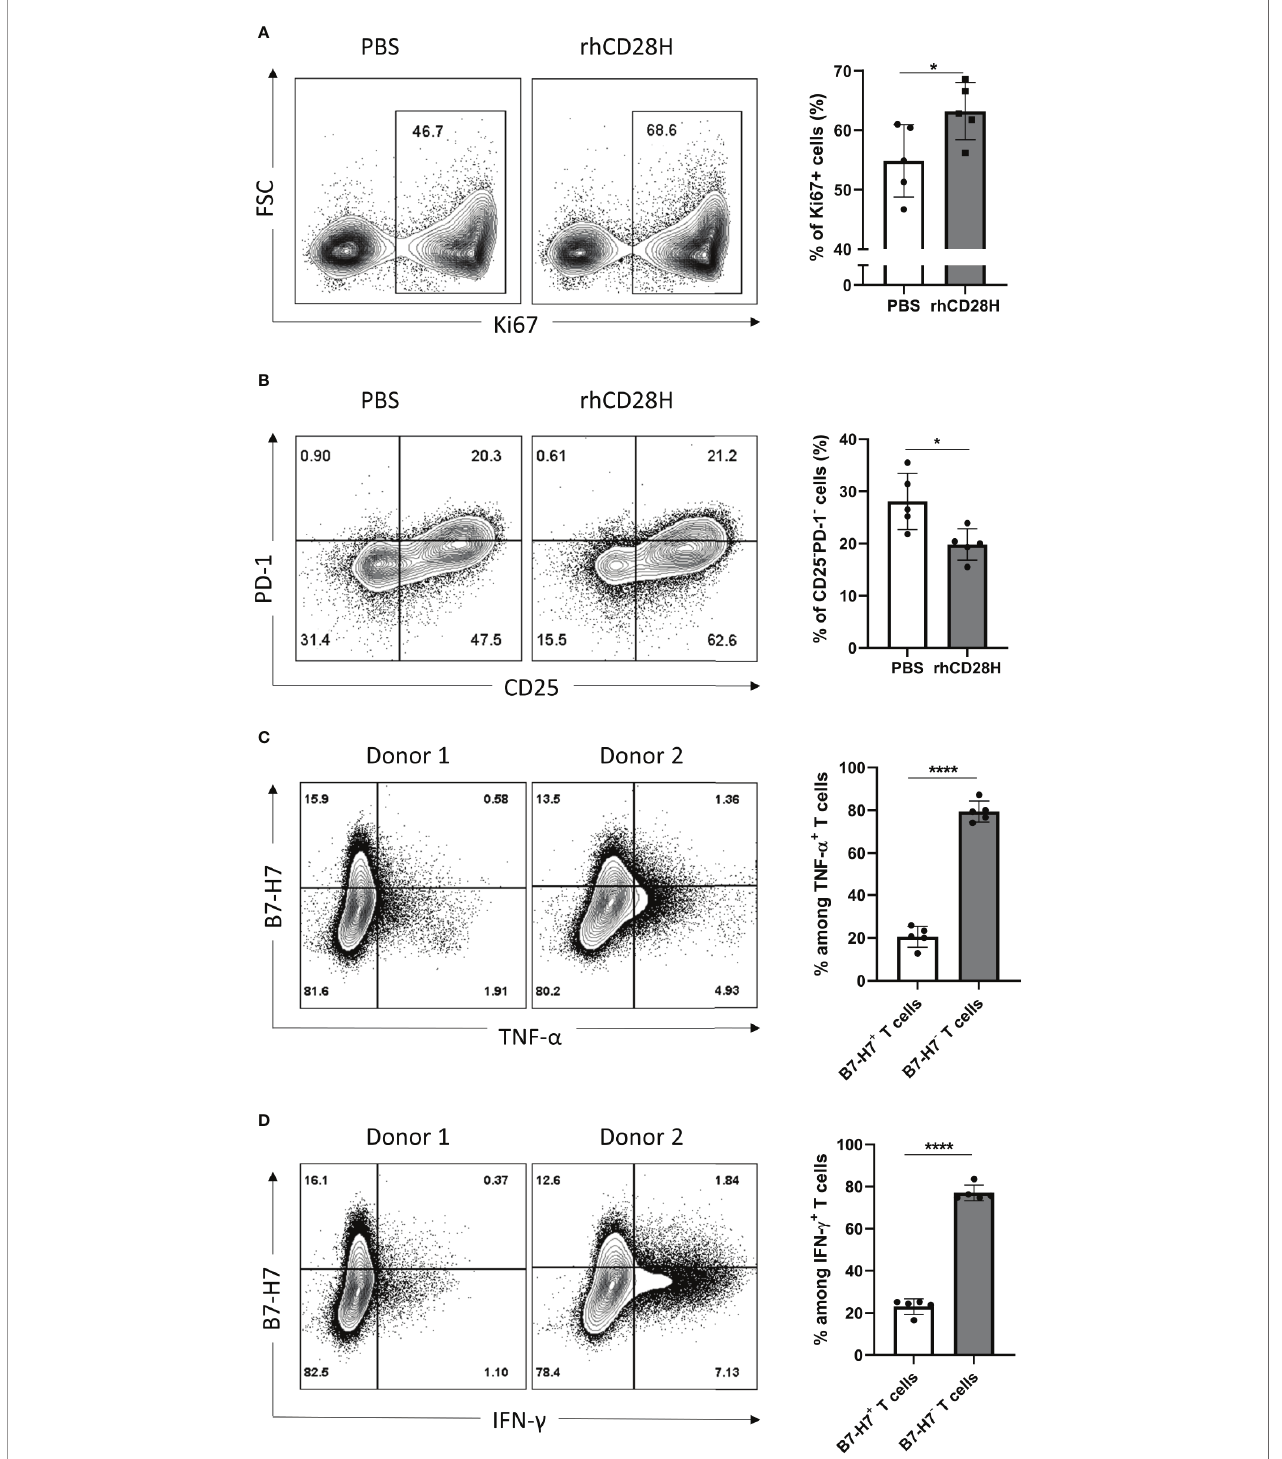
FIGURE 4 | Blocking B7-H7 enhances T cell proliferation. Puri fi ed T cells were activated with suboptimal 1/10 TransAct ™ dose (1:1000) for three to four days in the presence of PBS or 5 µg/ml of recombinant human CD28H (rhCD28H) and stained for (A) ki67 or (B) CD25 and PD1, n=5. Puri fi ed T cells were activated with recommended dose of TransAct ™ (1:100) for three days and stained for B7-H7, (C) TNF- a and (D) IFN- g , n=5. Dot plots from two representative donors are shown. Cells were gated for live and single cells. *p < 0.05, ****p < 0.0001, unpaired Student ’ s T